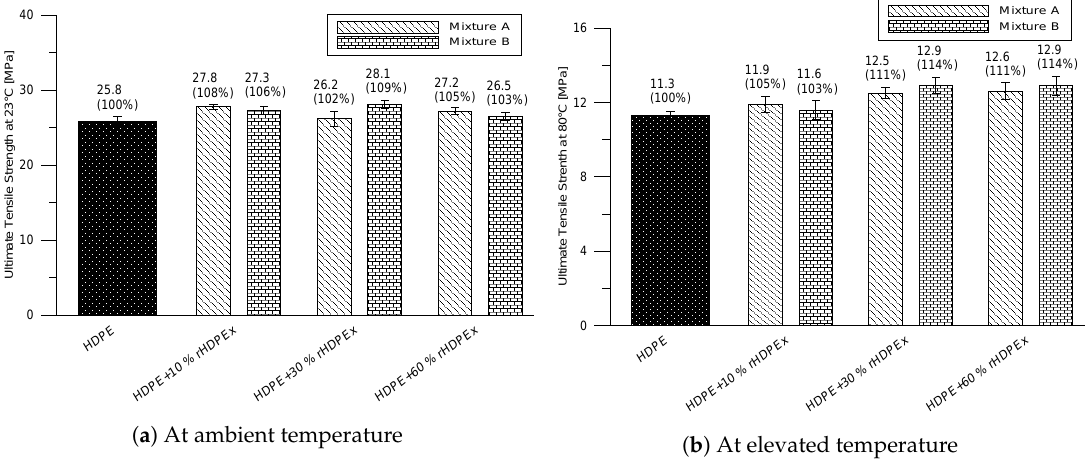
Figure 5. Ultimate tensile strength of mixtures A,